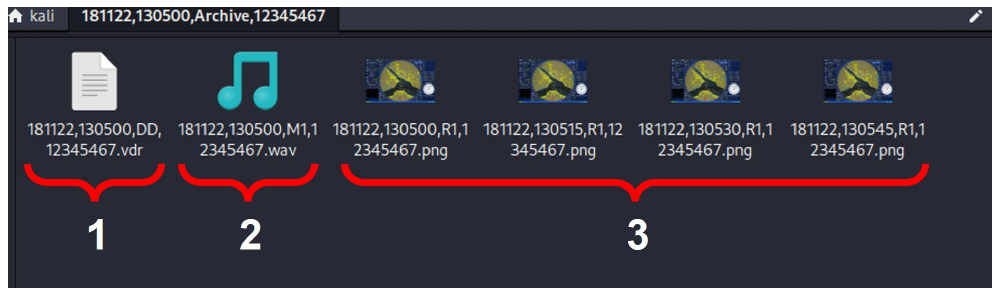
Figure 3. Example archived zip file with three types of voyage